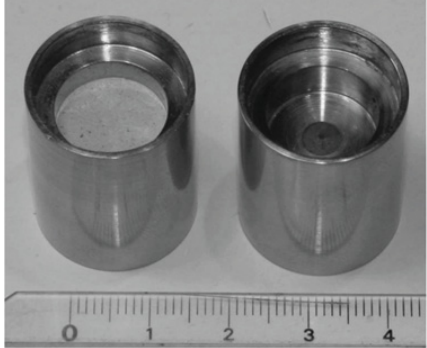
Figure 8. First prototypes of a superleak filter. They employ compressed Al 2 O 3 powder with grain sizes 100nm and 25 nm,